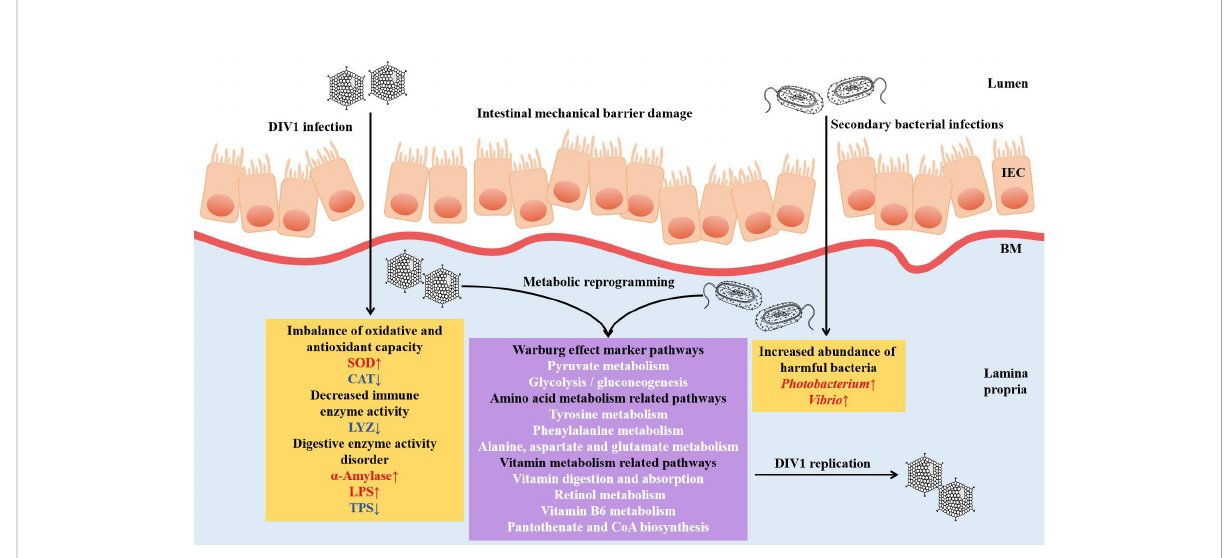
FIGURE 11 Proposed schematic diagram of secondary bacterial infection and metabolic reprogramming of M. japonicus induced by DIV1 infection. IEC, intestinal epithelial cells; BM, basement membrane; SOD, superoxide dismutase; CAT, catalase; LYZ, lysozyme; LPS, lipase; TPS,